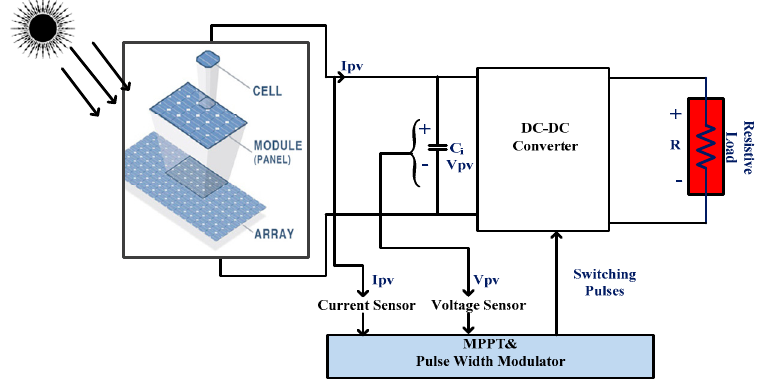
Figure 2. Block diagram of a photovoltaic (PV) fed high step-up boost converter system.